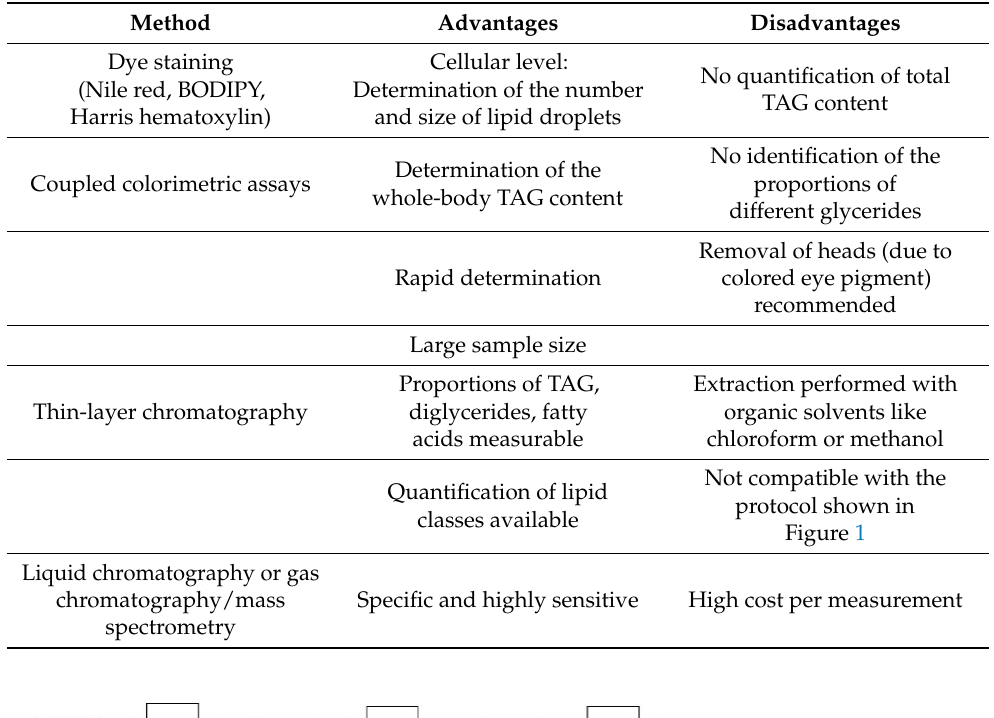
Table 1. Methodological overview of the determination of triacylglycerides (TAGs) with advantages and disadvantages.